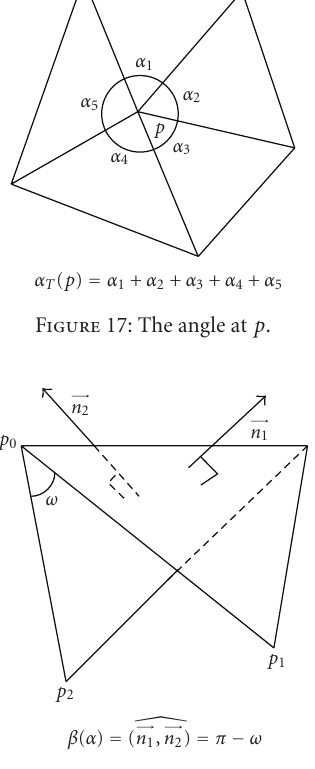
Figure 18: Dihedral angle of the edge.